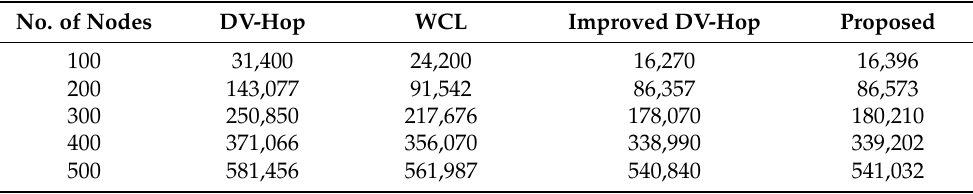
Table 13. Impact of node density on energy consumption.